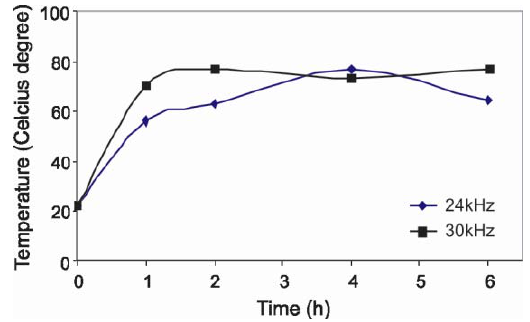
Fig. 3. Variation in temperature in kaolin slurries during ultra- sound irradiation